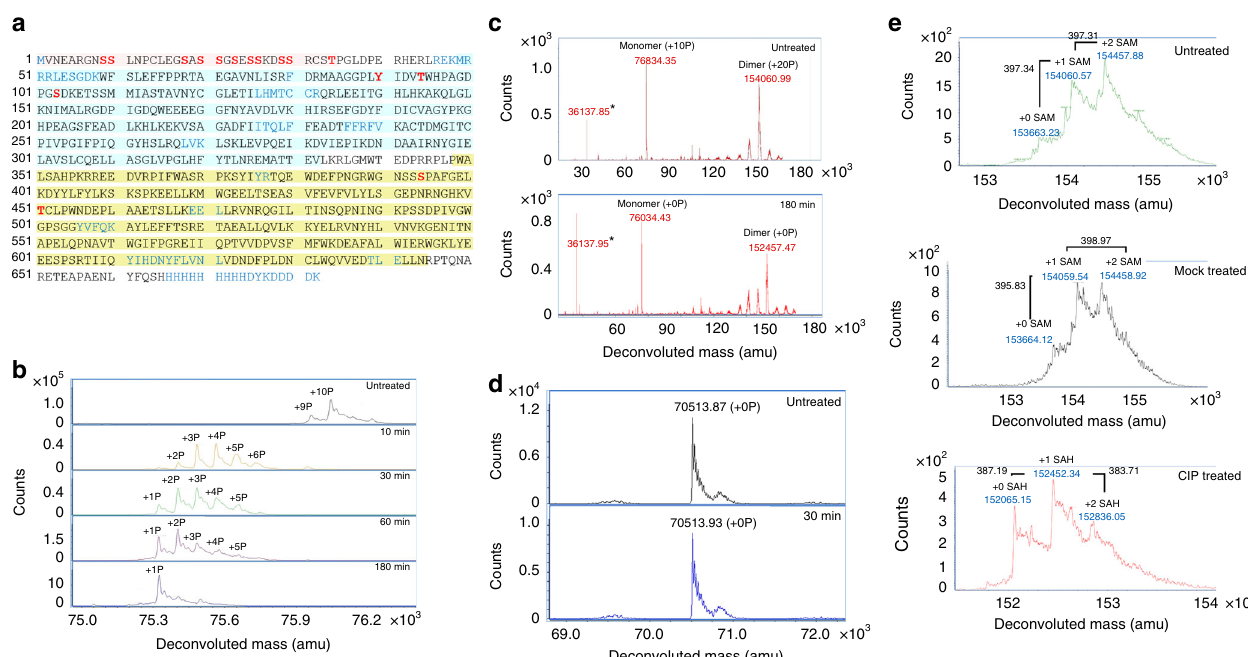
Fig. 2 Phosphorylation status of Hs MTHFR 1 – 656 and Hs MTHFR 38 – 644 . a Phosphorylation mapping of Hs MTHFR 1 – 656 . The protein sequence is given as amino acids in single letter code, including the C-terminal His/ fl ag-tag (underlined). Black font represents amino acids identi fi ed by the mass spectrometer (covered), blue font represents amino acids not identi fi ed (non-covered), red font represents phosphorylated amino acids. Domains are coloured as in Fig. 1. b Dephosphorylation of Hs MTHFR 1 – 656 following treatment with CIP. Treatment time at 37 °C is given. Large number above peaks represents number of phosphate groups attached. Proteins were analysed by denaturing mass spectrometry. amu, atomic mass units. c Native mass spectrometry analysis of Hs MTHFR fi ed (untreated) protein. Monomer represents protein bound to 1 FAD plus 10 1 – 656 before and after treatment with CIP. Upper panel: as puri phosphate groups (expected mass: 76831.16 amu); dimer represents protein bound to 2 FADs and 1 SAM plus 20 phosphate groups (expected mass: 154060.74 amu). Lower panel: protein following 180 min treatment with CIP. Monomer represents protein bound to 1 FAD (expected mass: 76031.16 amu); dimer represents protein bound to 2 FADs and 1 SAH (expected mass: 152446.74 amu). Expected sizes: protein without fi rst methionine, 75245.6 amu; FAD, 785.56 amu; SAM, 398.44 amu; SAH, 384.42 amu, phosphate, 80.00 amu. * indicates a truncated protein representing amino acids 353 – 663 (expected mass: 36136.6amu). d Hs MTHFR 38 – 644 before and after treatment with CIP. Treatment time at 37 °C is given. Protein was analysed by denaturing mass spectrometry. e Native mass spectrometry of Hs MTHFR 1 – 656 identifying sequential binding of SAM or SAH. Graphs represent areas zoomed in on dimeric protein. Upper panel: As puri fi ed (untreated) protein. Middle panel: control protein (heated in assay buffer for 180 min without CIP). Bottom panel: treated protein (heated in assay buffer for 180 min with CIP). Expected size of protein with 2 FAD bound and 20 phosphates: 153662.3. Expected size of protein with 2 FAD bound and 0 phosphates: 152062.32. Expected size of SAM: 398.44, SAH: Table 1, compared to non-phosphorylated Hs MTHFR 38 – 644 , phosphorylated Hs MTHFR